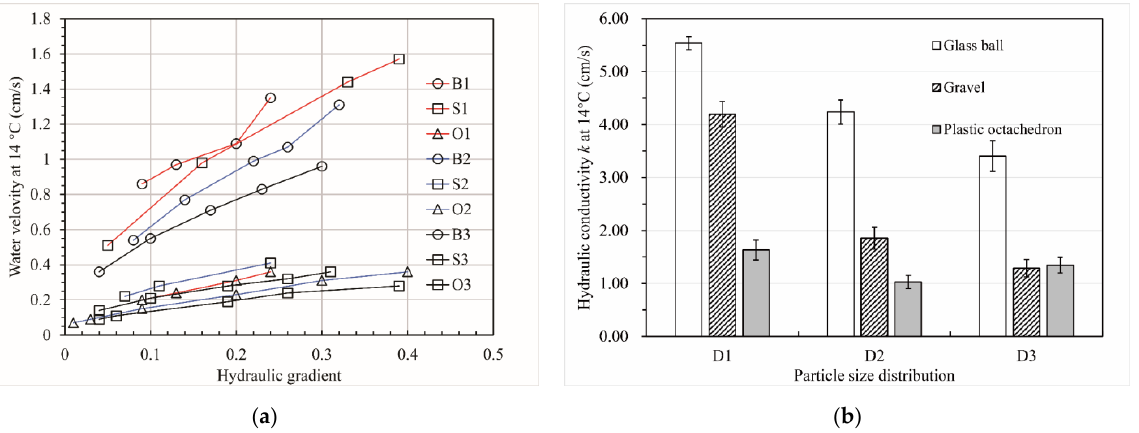
Figure 17. Permeability test results of the packs. ( a ) The relationship between the hydraulic gradient and the flow velocity of the pack. ( b ) The hydraulic conductivity of the pack. The error bars in the figure were based on the standard deviations.